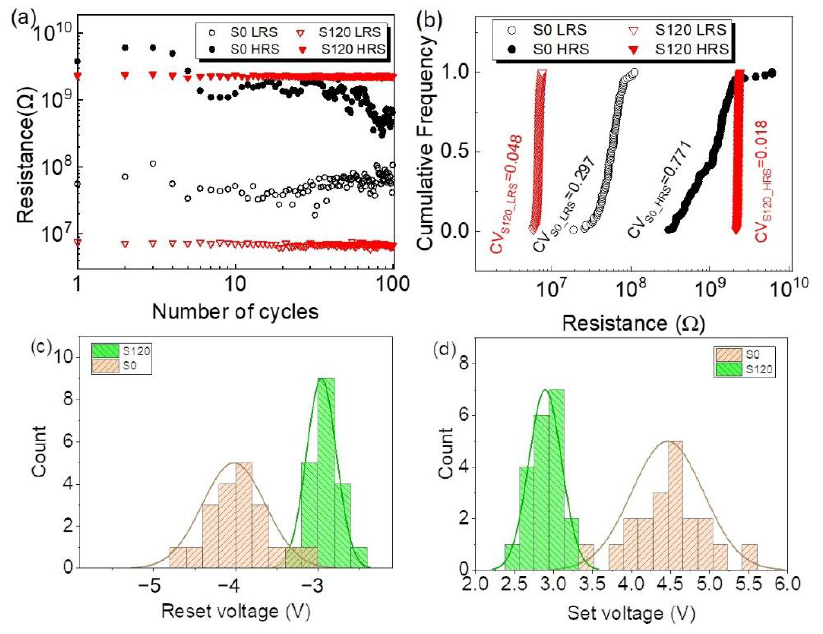
Figure 3. ( a ) The HRS and LRS resistances during 100 consecutive switching cycles with ( b ) their cumulative frequencies. Counts versus ( c ) reset voltage and ( d ) set voltage of devices.